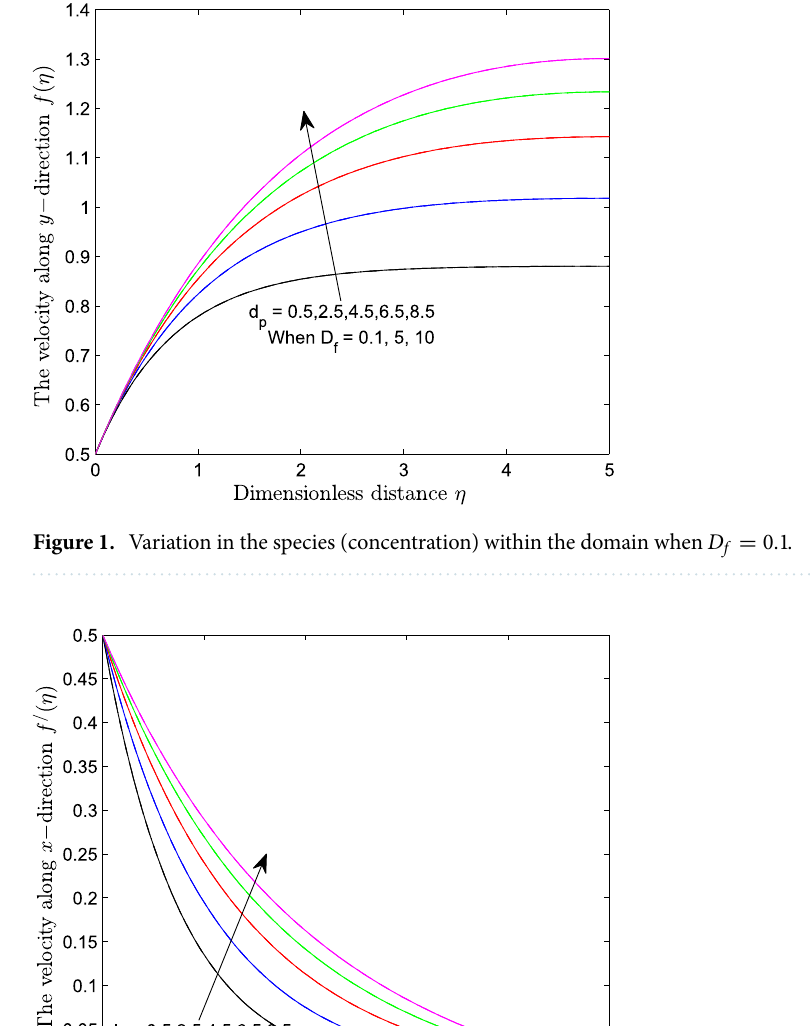
Figure 2. Variation in the species (concentration) within the domain when D f